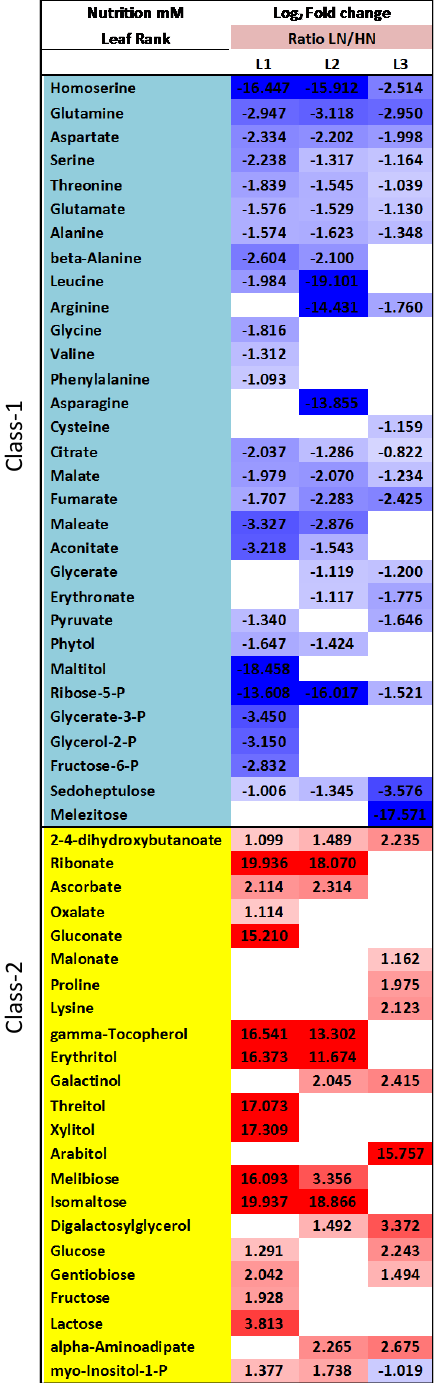
Figure 5. Primary leaf metabolite changes in low nitrate conditions (LN) compared to high nitrate (HN) conditions. Values for each metabolite were first measured as peak area normalized to the ribitol internal standard and to the mg FW (see Supplementary Data Set 1). The Log 2 of the fold changes in LN leaves from HN leaves were calculated for each leaf L1, L2 and L3. Data used to calculate the Log 2 Fold changes are the mean of eight biological repeats. The values go from low (blue) to high (red) metabolite-relative contents in LN leaves compared to HN leaves. The scale bar of red and blue shades range from − 5 to +5. Only metabolites significantly different in LN leaf compared to HN leaf are shown. Significance was determined on the normalized peak areas using T -test ( n = 8; p <